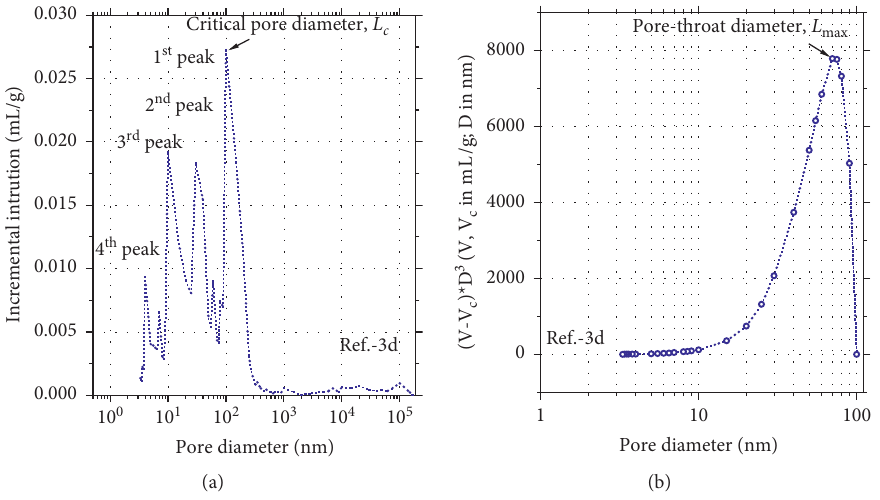
Figure 2: Example of typical MIP derivative curves for L